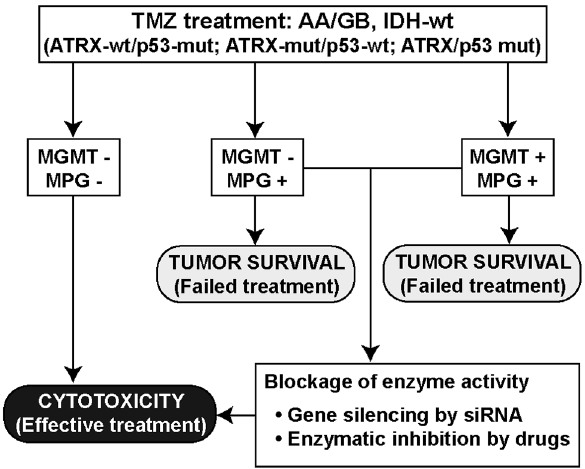
Figure 4. Proposed strategy for TMZ chemotherapy sensitization in malignant glioma. Direct inhibition of MGMT and MPG DNA repair enzymes is proposed as possible therapeutic approach to overcome